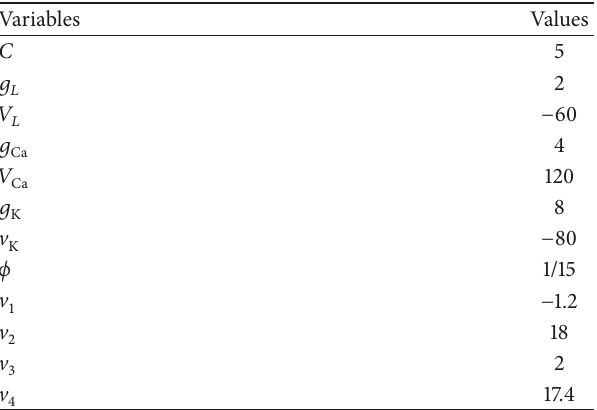
Table 1: Variables of a Morris-Lecar neuron. Variables